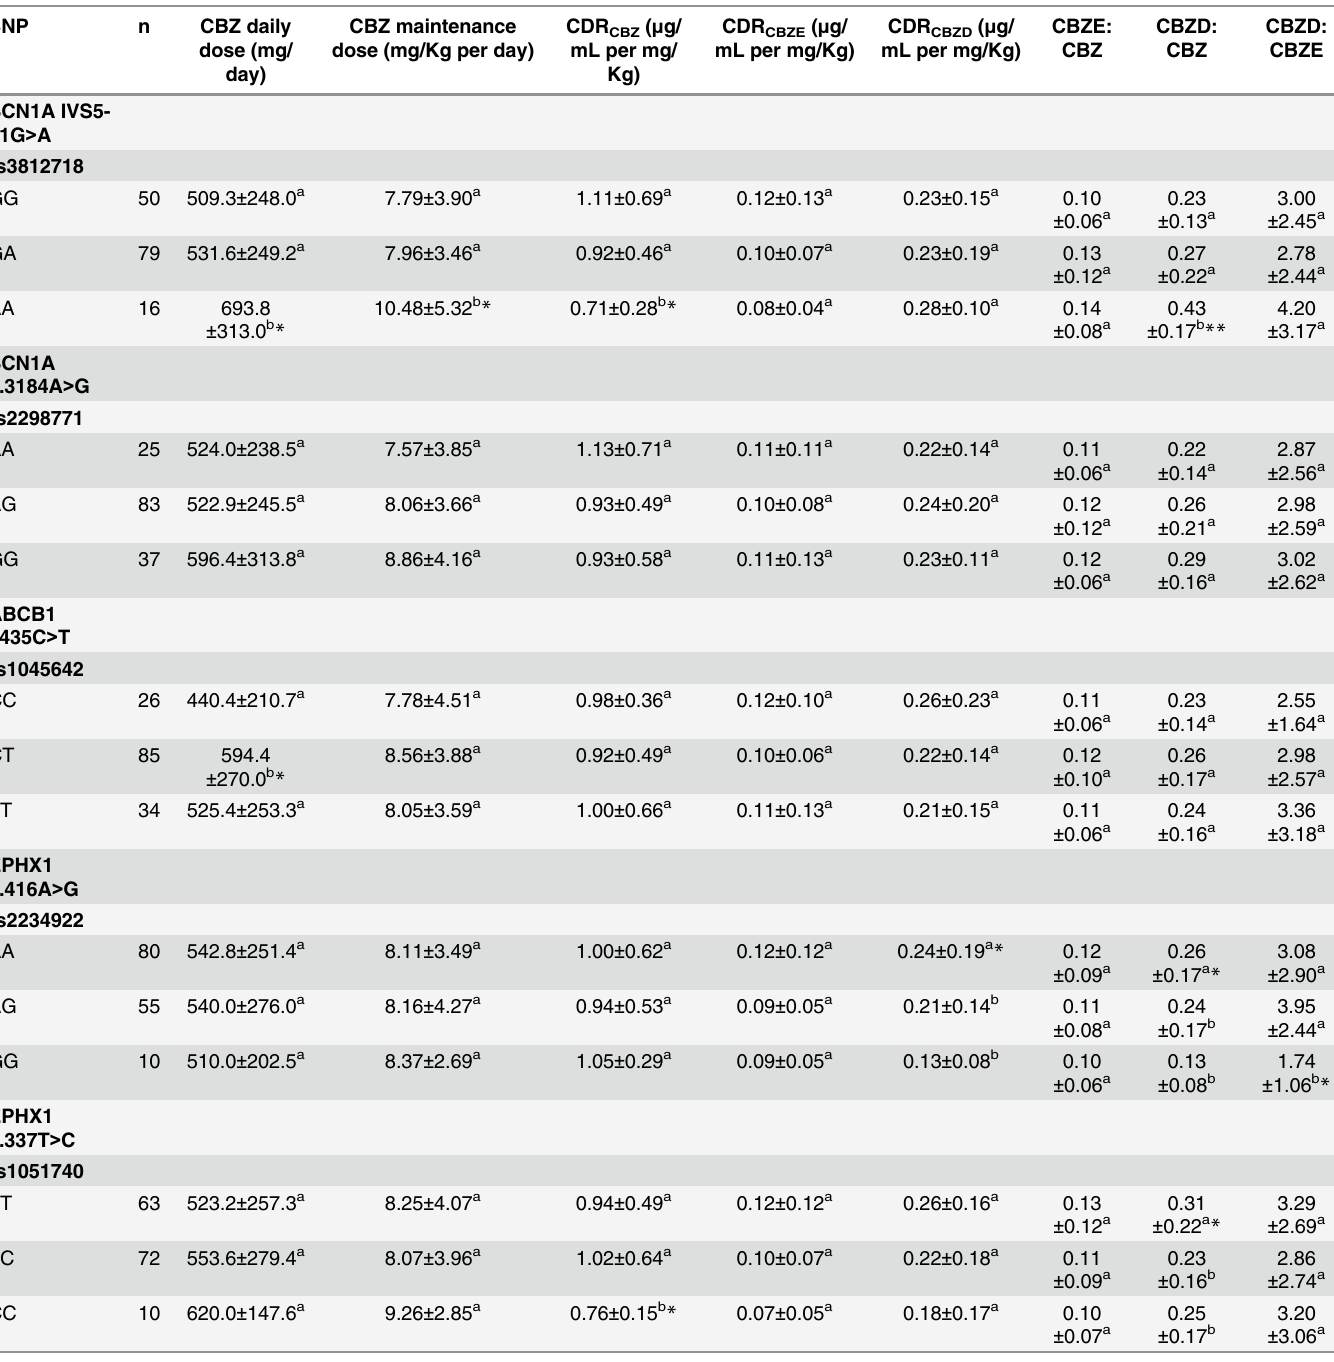
Table 2. CBZ daily dose, maintenance dose, concentration/dose adjusted ratios of CBZ, CBZE, CBZD and their concentration ratios stratified by individual SNPs genotypes. Data are mean ± standard